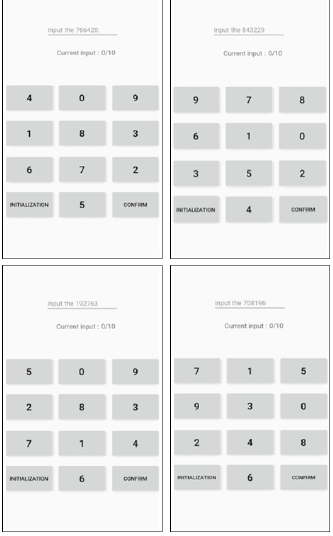
Figure 4. Unique